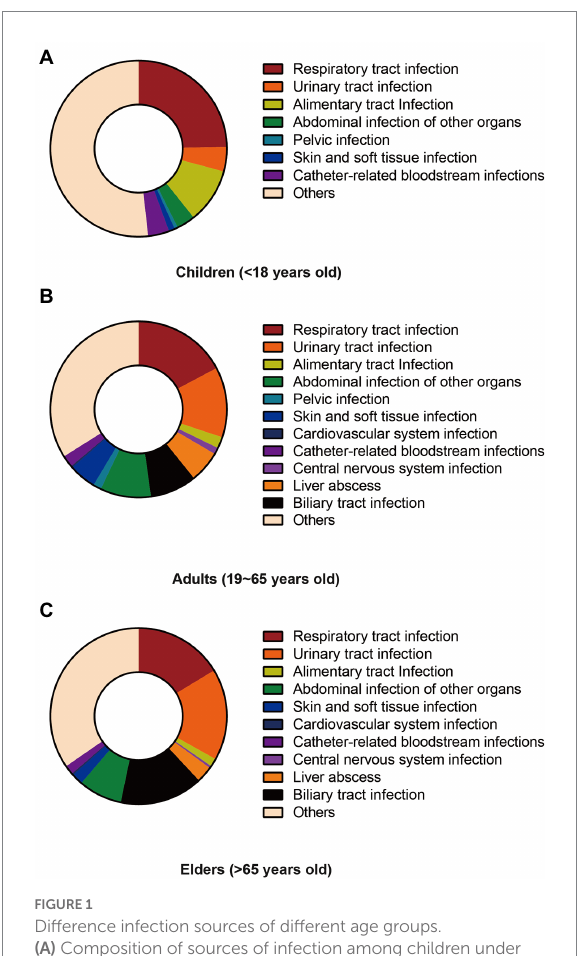
FIGURE 1 Difference infection sources of different age